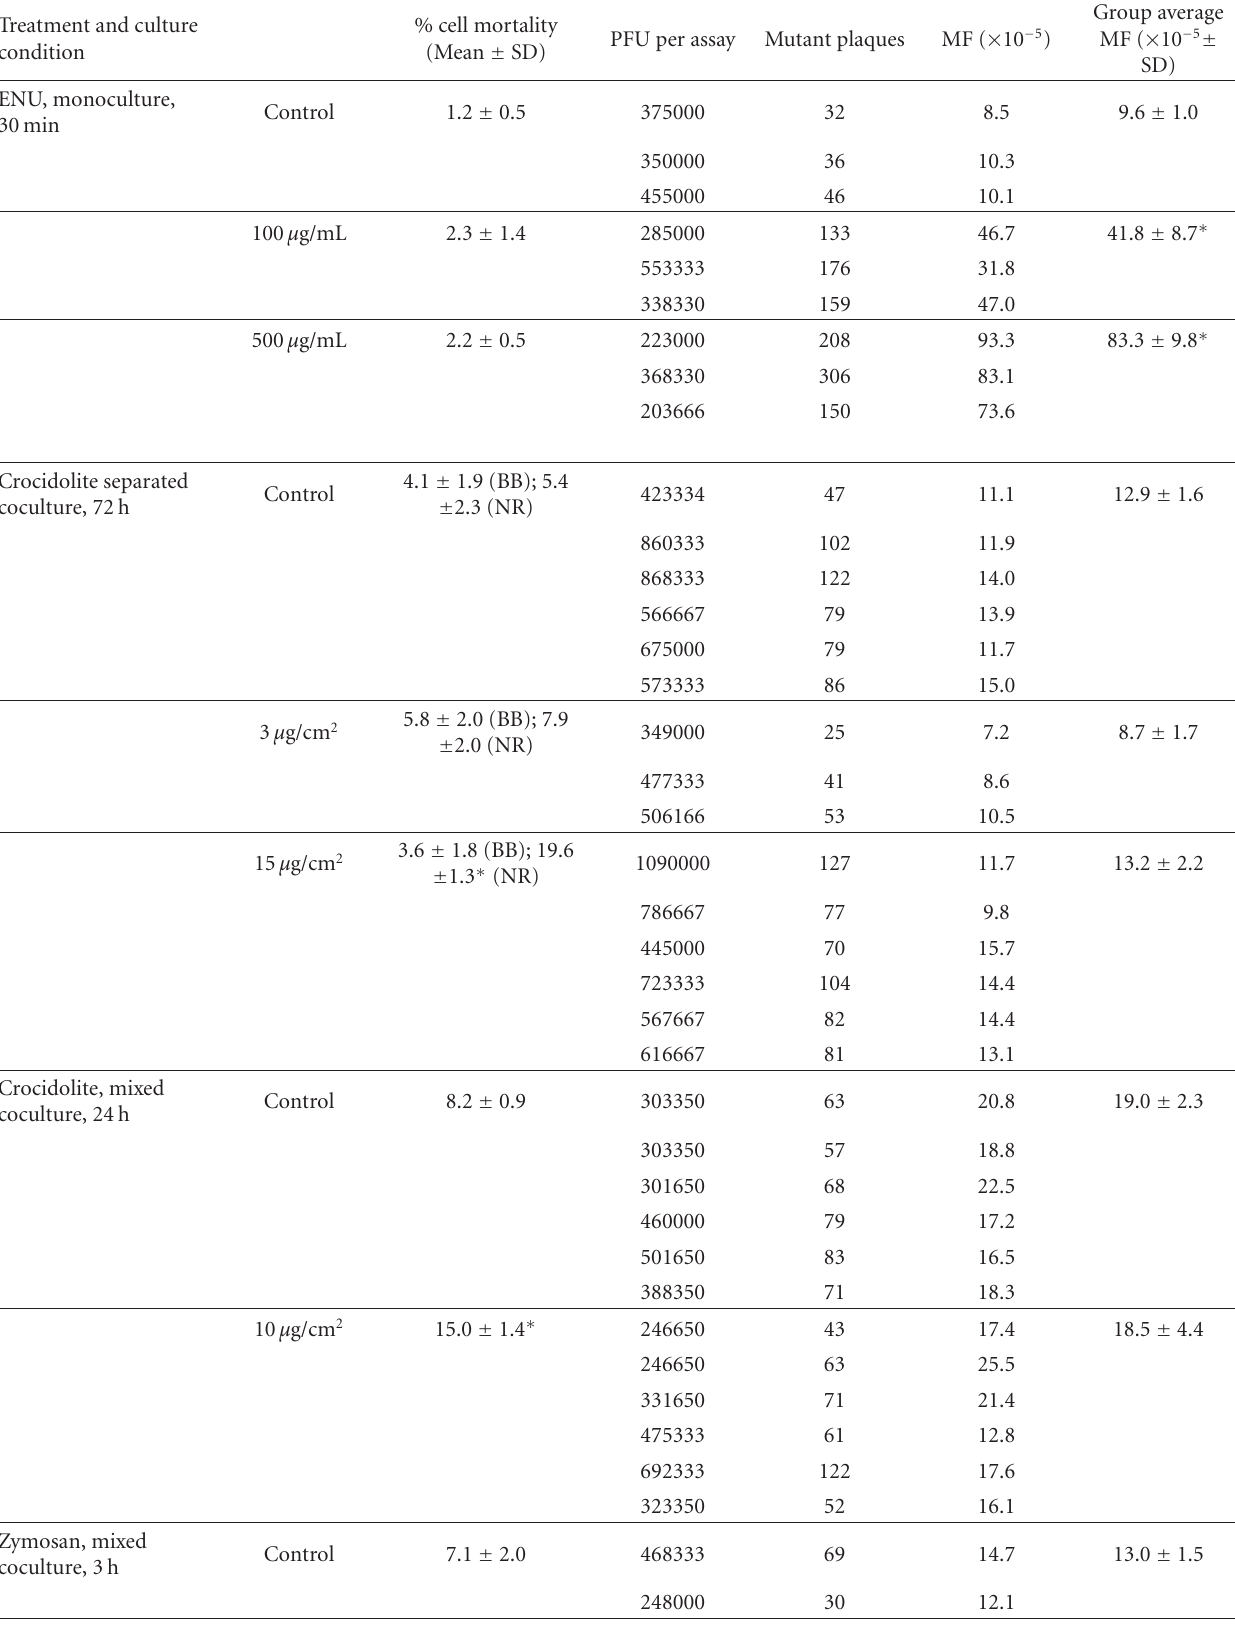
Table 3: Cytotoxicity and mutation frequencies in Big Blue cells following various treatments in mono- or coculture with NR8383 cells. Treatment and